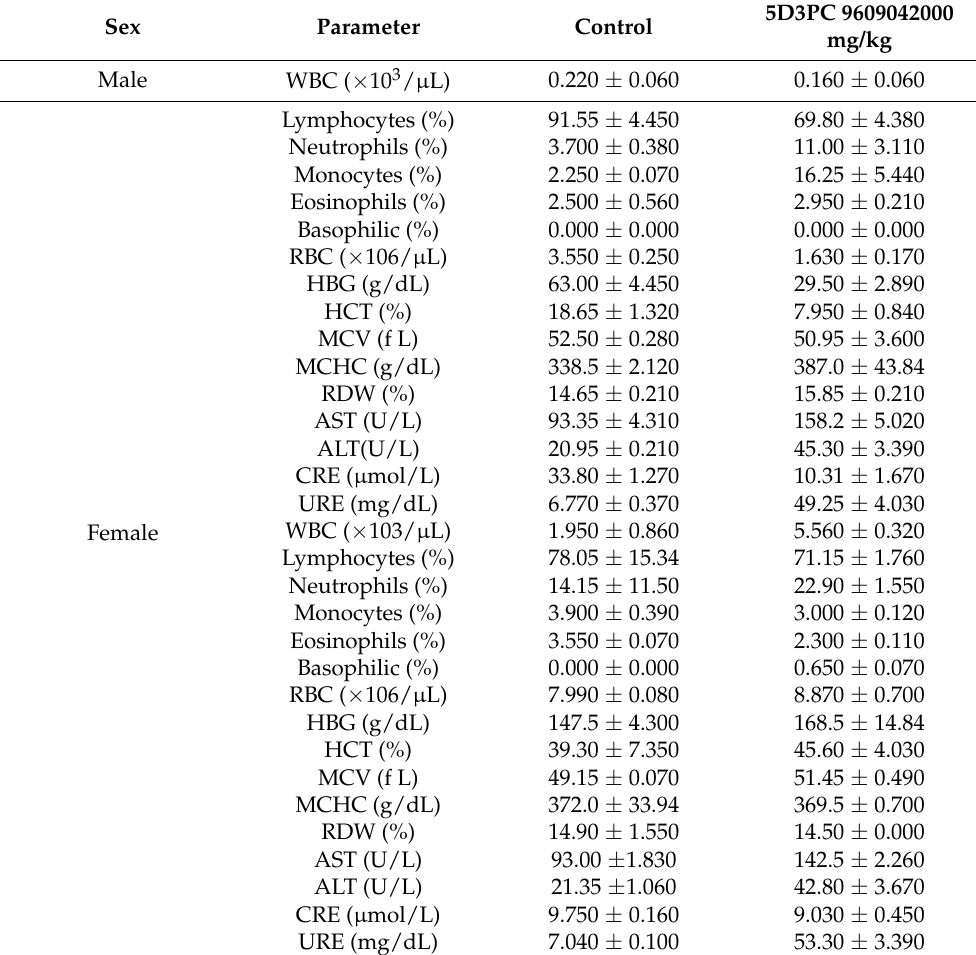
Table 1. Effect of 5D3PC (2000 mg/kg) on hematological and biochemical profilin ICR mice from 14 days acute toxicity study.